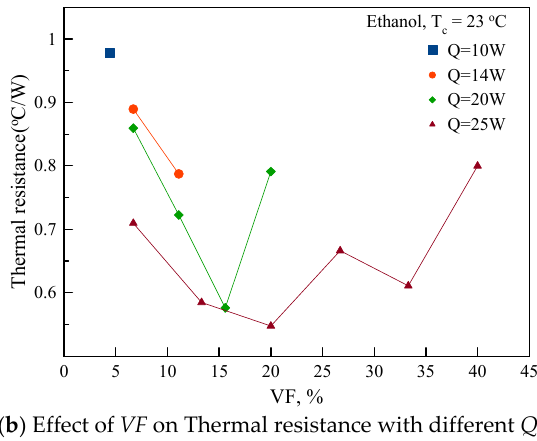
Figure 4. Effect of Charged Amount ( VF : Volume Fraction) on thermal resistance.